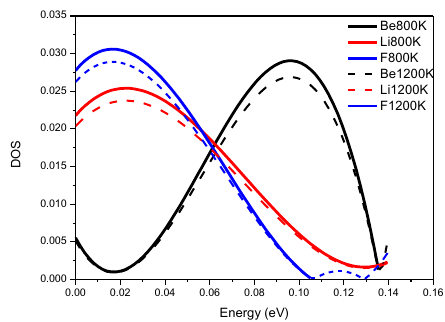
Fig. 5. Calculated DOS for Be, F, Li in liquid molten salt LiF- BeF 2 at 800 K and